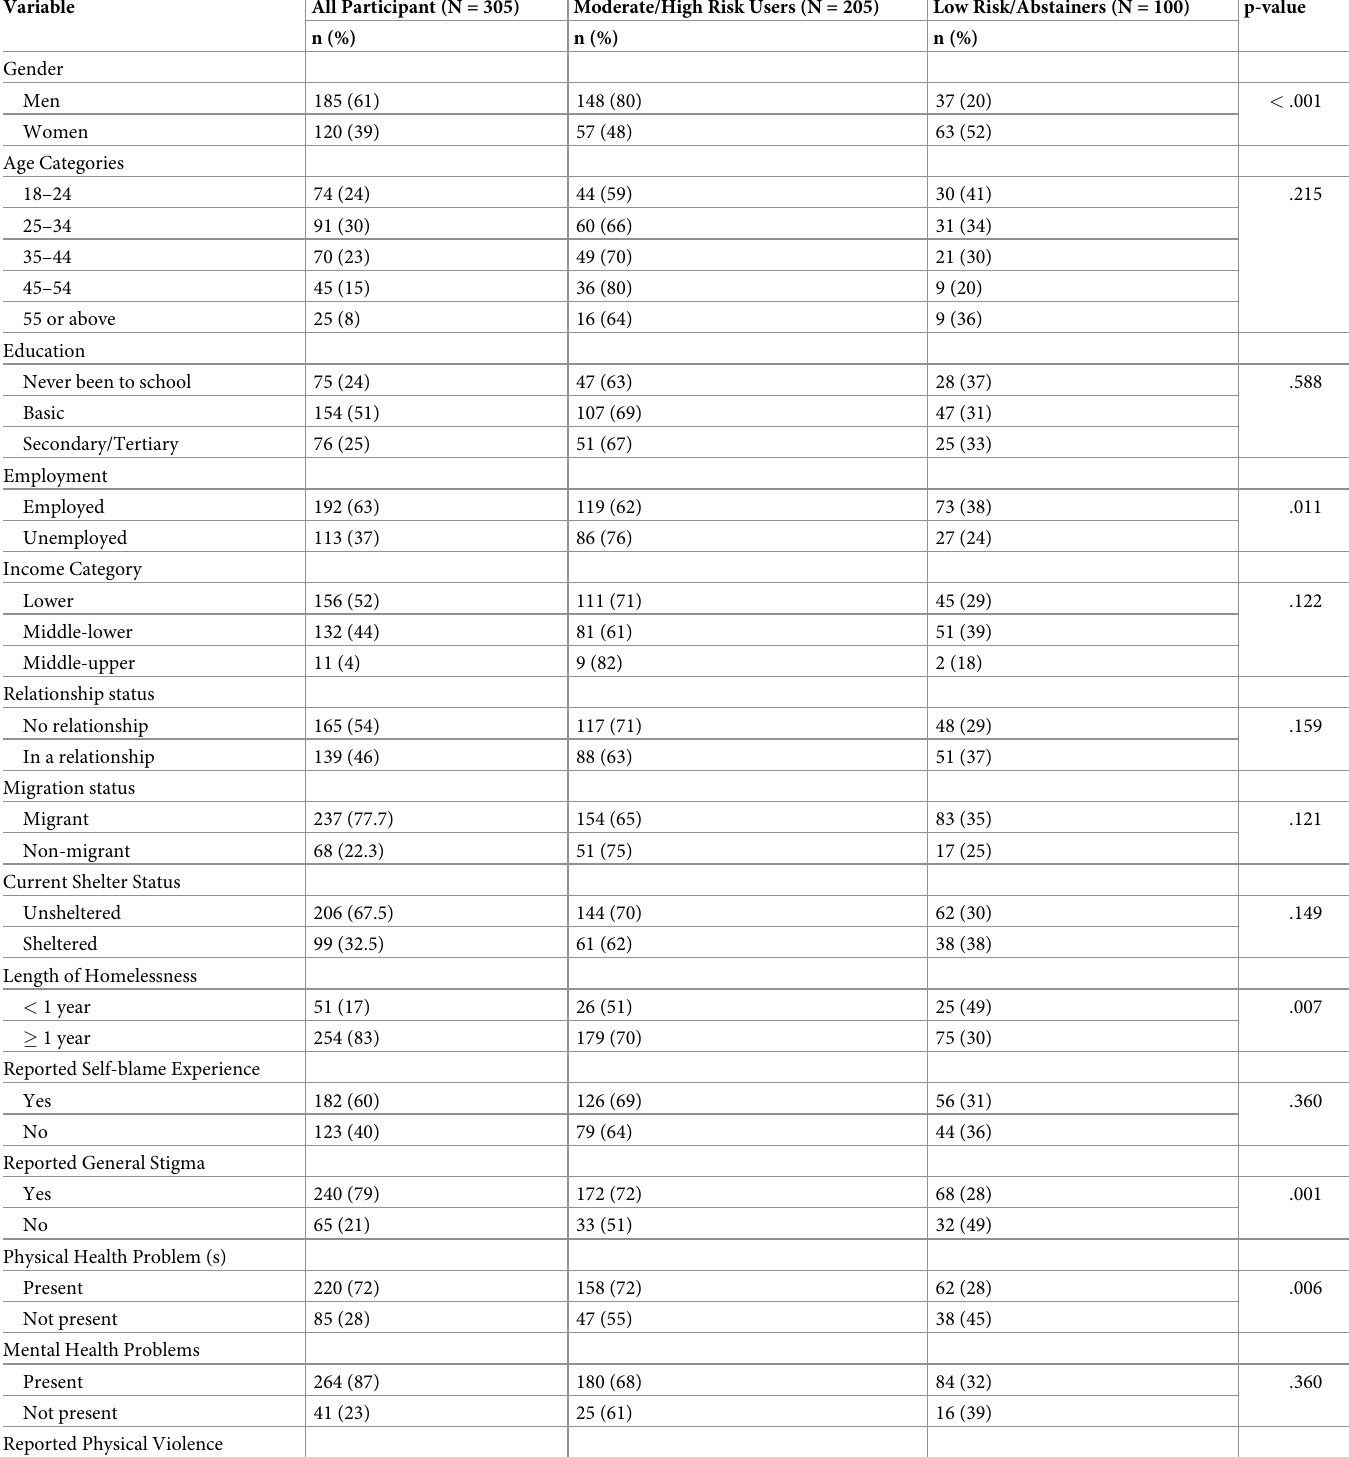
Table 3. Characteristics of study respondents by substance use risk